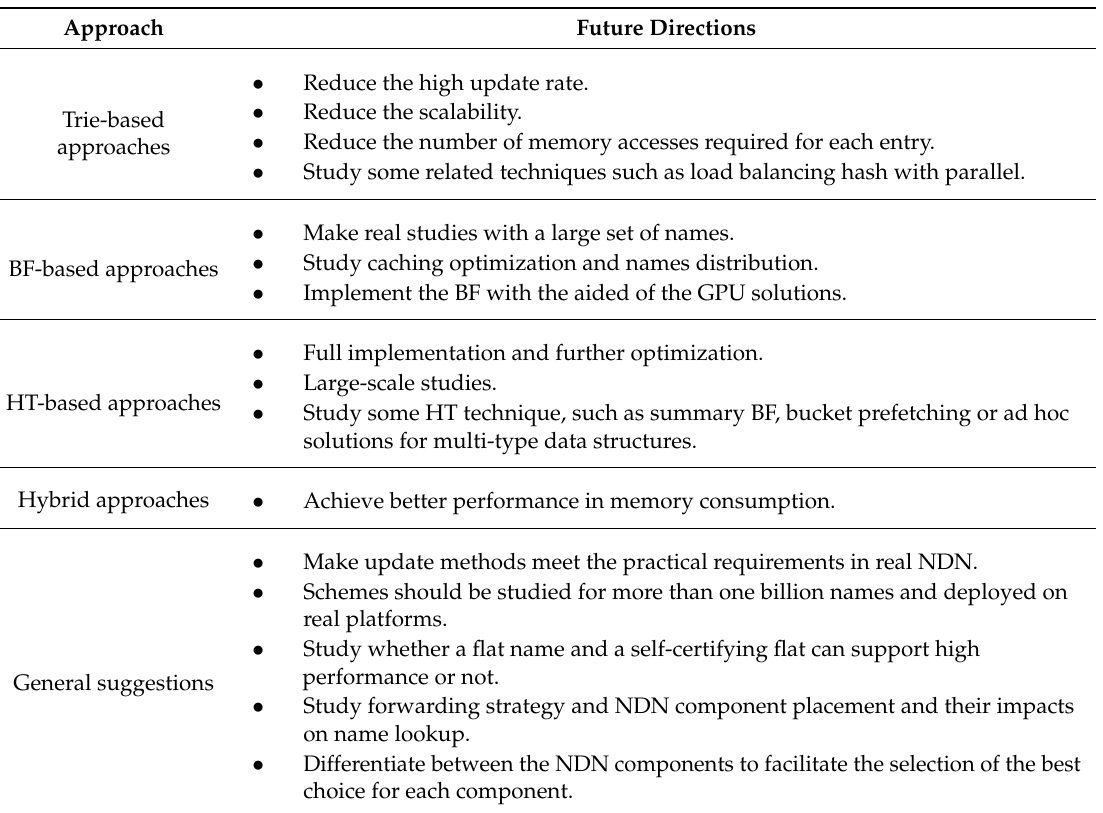
Table 7. Future directions for NDN name